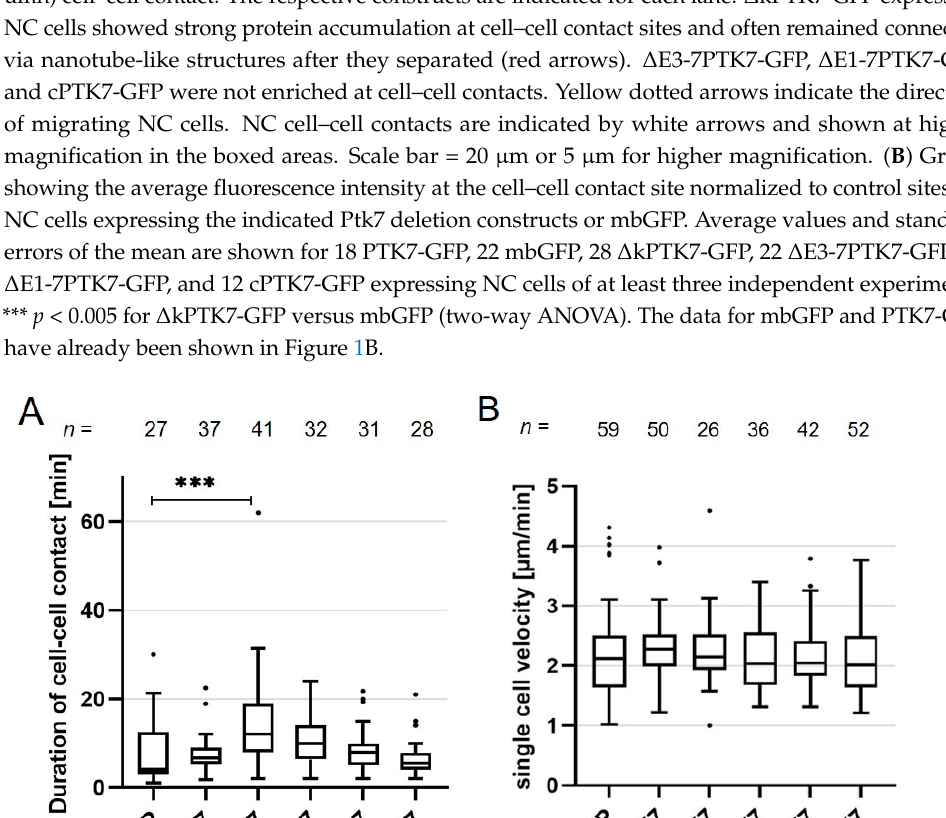
Figure 4. ∆ kPTK7 overexpressing NC cells stay longer in cell–cell contact compared to controls, while single cell velocity is not affected. ( A ) Box plot showing cell–cell contact time (in minutes) during collision of NC cells expressing various Ptk7 constructs. NC cells expressing ∆ kPTK7-GFP exhibit a significantly increased contact time compared to the control. ( B ) Graph blotting single cell velocity of NC cells expressing the indicated Ptk7 constructs. Box and whiskers plots summarize results of at least three independent experiments, the number of analyzed cells for each condition is indicated at the top. The box extends from the 25th to the 75th percentile, with whiskers with maximum 1.5 IQR. The median is plotted as a line inside the box. *** p < 0.005 (Kruskal–Wallis test).